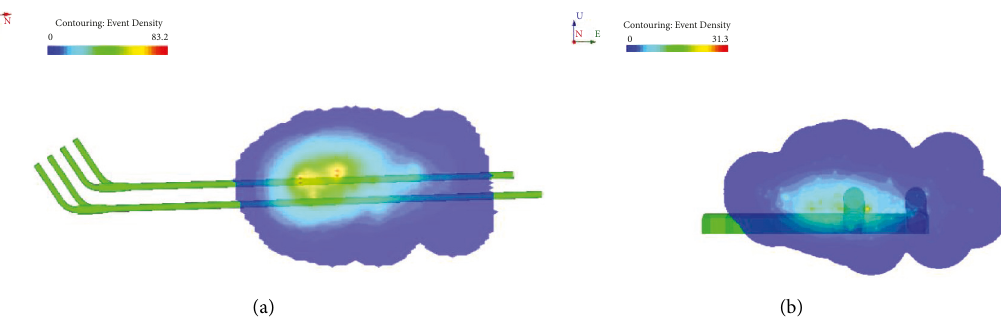
Figure 17: Density cloud map of microseismic events in the tailrace tunnel. (a) Planform. (b) Left view.